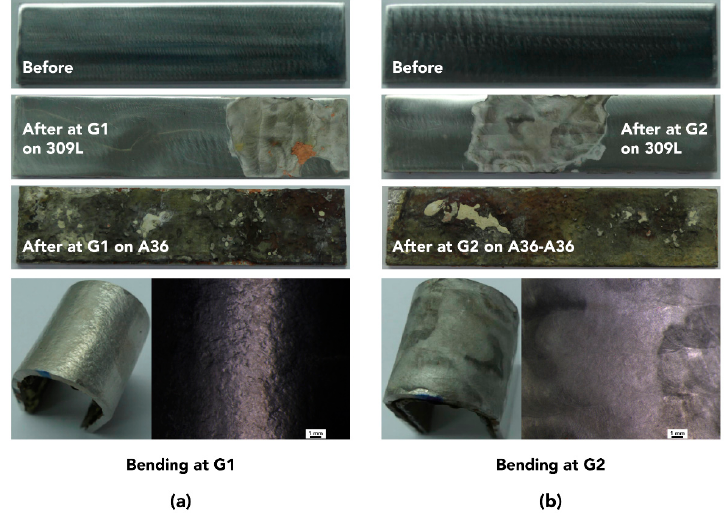
Figure 14. The intergranular corrosion testing results: ( a ) Cladding layer over weldment (G1); ( b ) Cladding-substrate layer over weldment (G2).